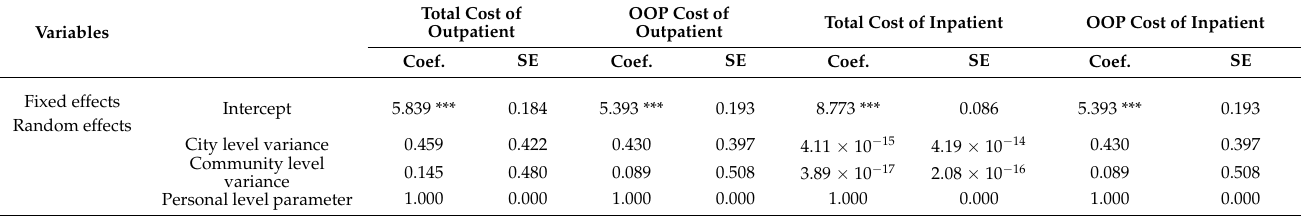
Table 4. Three-level empty model of influencing factors of health service utilization.